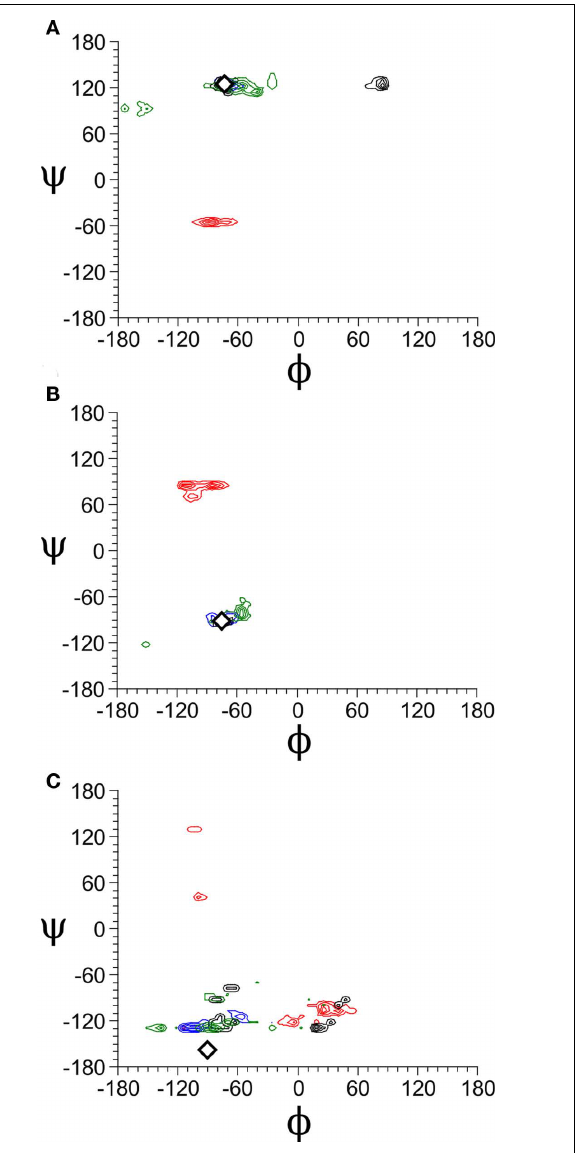
FIGURE 3 | Ramachandran-like plots obtained for cognate docking to PDB 1SL5. (A) Plot obtained for Gal β (1 → 4)GlcNAc linkage. (B) Plot obtained for Fuc α (1 → 3)GlcNAc linkage. (C) Plot obtained for GlcNAc β (1 → 3)Gal linkage.The φ / ψ angles were calculated for each linkage in each pose given by each of the four programs.The angles were calculated according to the IUPAC convention (Liebecq, 1992); for a given 1 → x linkage, φ is the dihedral of O 5 -C 1 -O 1 -C x , and ψ is the dihedral of C 1 -O 1 -C x -C x − 1 . Contour plots were generated using QTIPLOT. Color guide: black – Glide, green – GOLD, red – Autodock, blue – DOCK.The crystal structure angle is highlighted by a white diamond in each